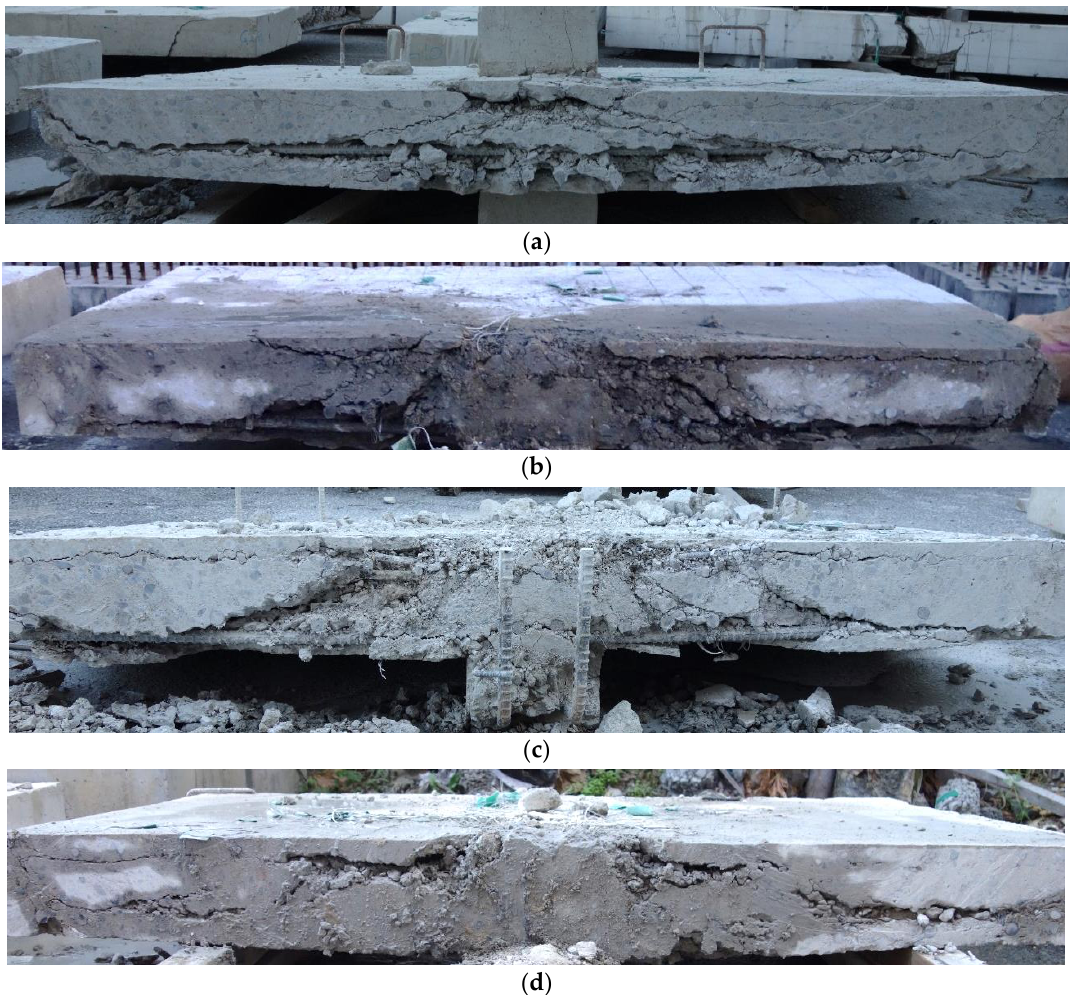
Figure 6. Distribution of cracks on specimens at maximum load: ( a ) Control; ( b ) G-246B.